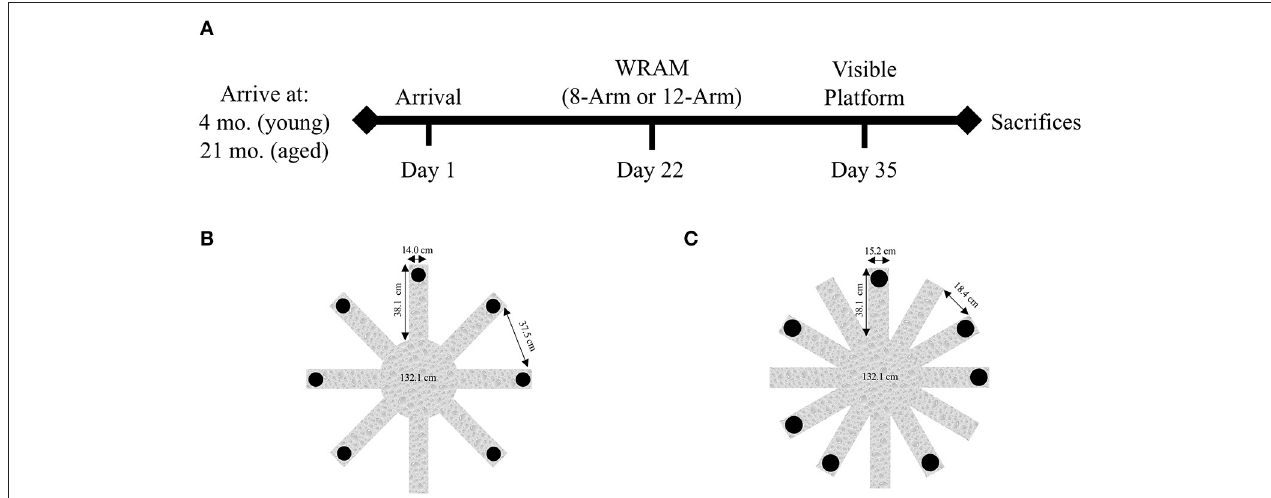
FIGURE 1 | Study timeline and WRAM configurations. (A) The study timeline depicts the age at arrival and the commencement of behavioral testing, including WRAM and VP. (B) The 8-Arm WRAM apparatus, with seven of the eight arms platformed. Besides the starting arm, all other arms in the 8-Arm WRAM are spatial working memory arms. (C) The 12-Arm WRAM apparatus, with seven of the 12 arms platformed, making for a total of seven working memory arms, like that of the 8-Arm WRAM. This maze, however, has five reference memory arms, allowing for the analysis of both spatial reference and working memory performance on the WRAM.